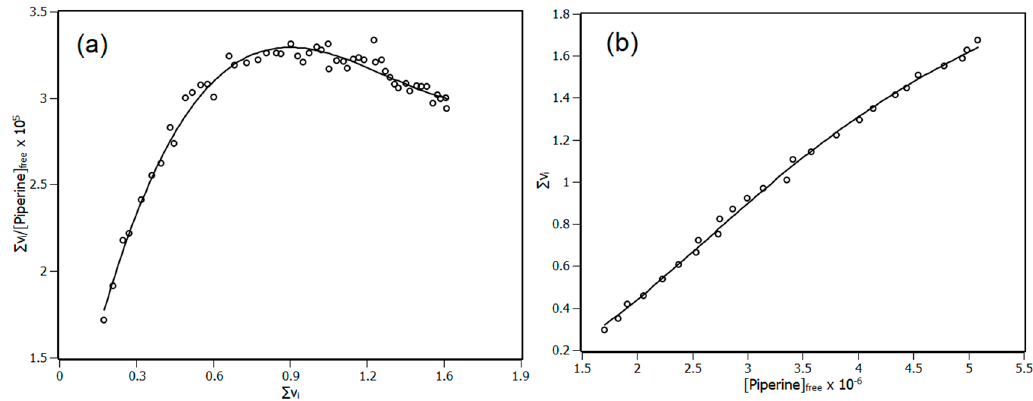
Figure 6. ( a ) Scatchard plot for the interaction of NBD and piperine obtained at 288 K based on interaction density function (IDF) data. ( b ) Hill plot for the interaction of NBD and piperine obtained at 288 K based on IDF data. R 2 > 0.99.